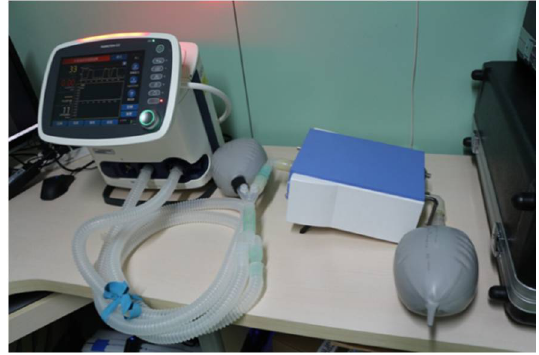
Figure 3. Experiment apparatus.